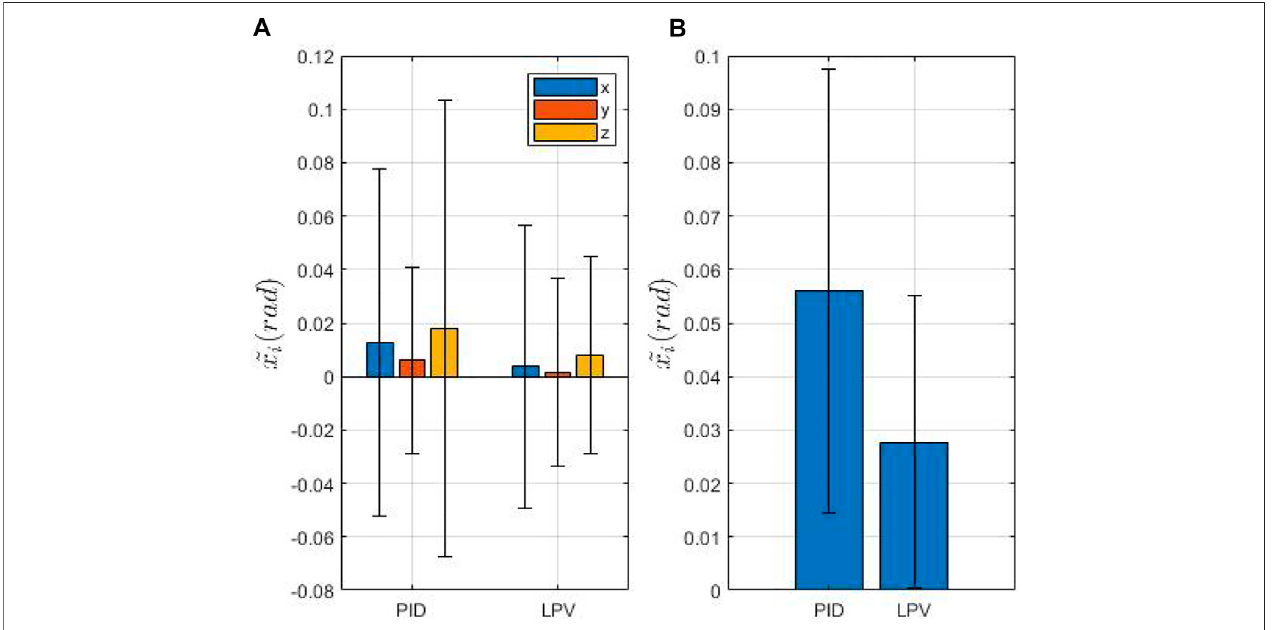
FIGURE 8 | Overview of the IPM orientation error at 20 cm of inter-magnetic distance. (A) shows the mean and standard deviation of the orientation error. (B) shows the mean and the standard deviation of the euclidean norm of the mean orientation error.